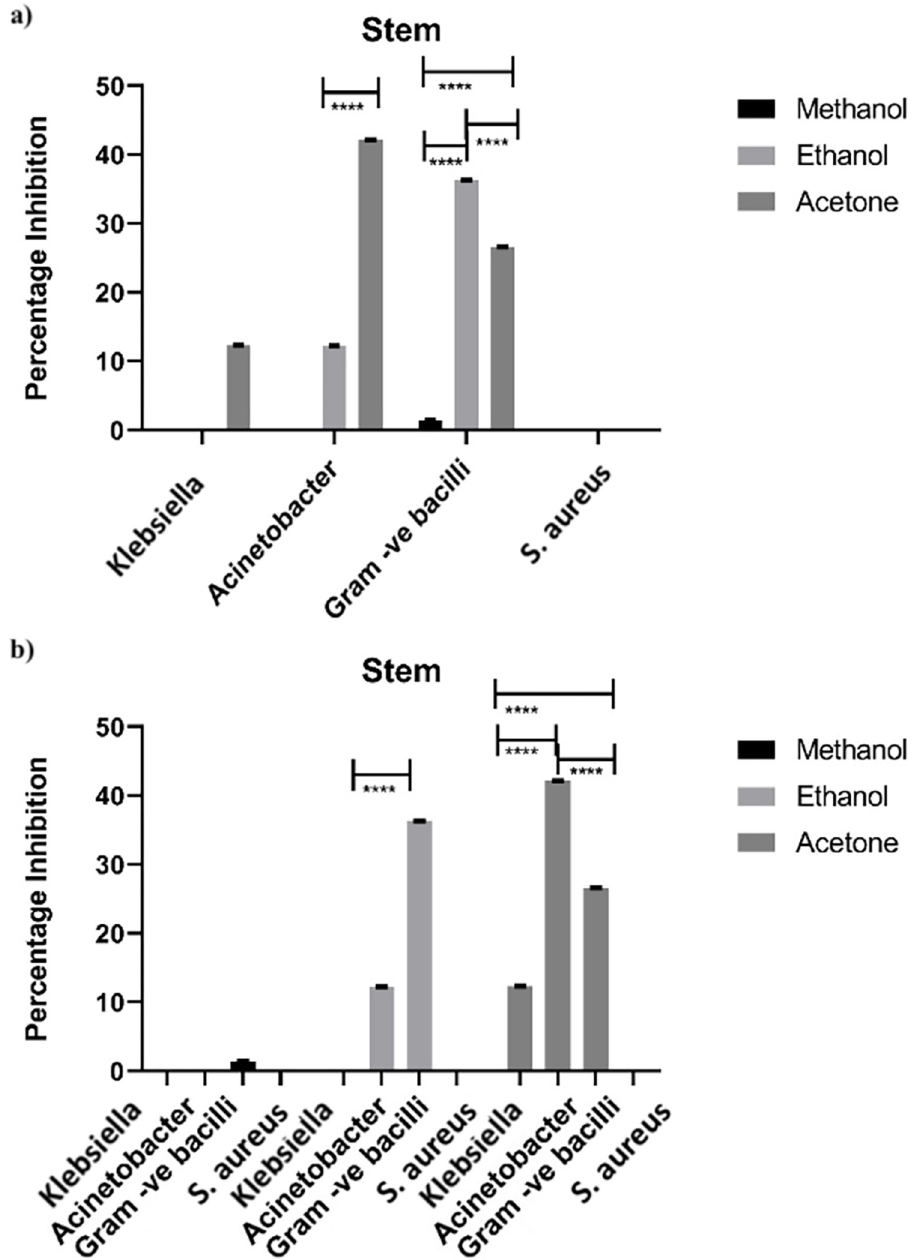
Fig 3. Statistical comparison of antimicrobial activity of stem against various bacteria (a) Effect of each solvent on individual bacterium. (b) Comparison of each solvent with all for selected bacterial spp. Bar represents ± SEM. Data was analyzed by two-way analysis of variance (ANOVA) (P < 0.001). * = significant, ns = non-significant.